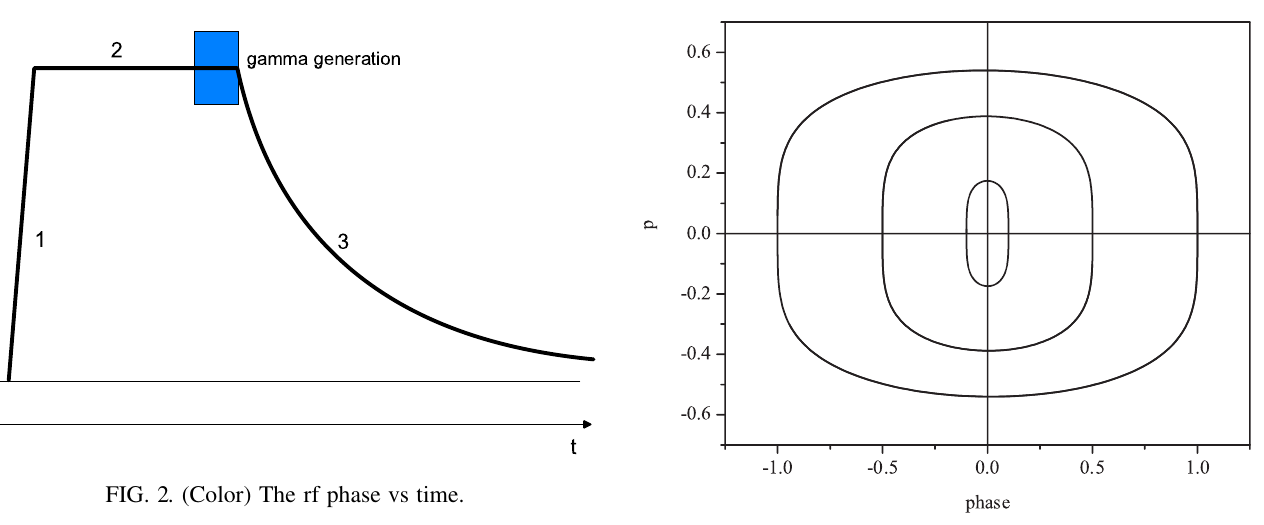
FIG. 4. The phase trajectory of the bunch center without excitation, damping, and